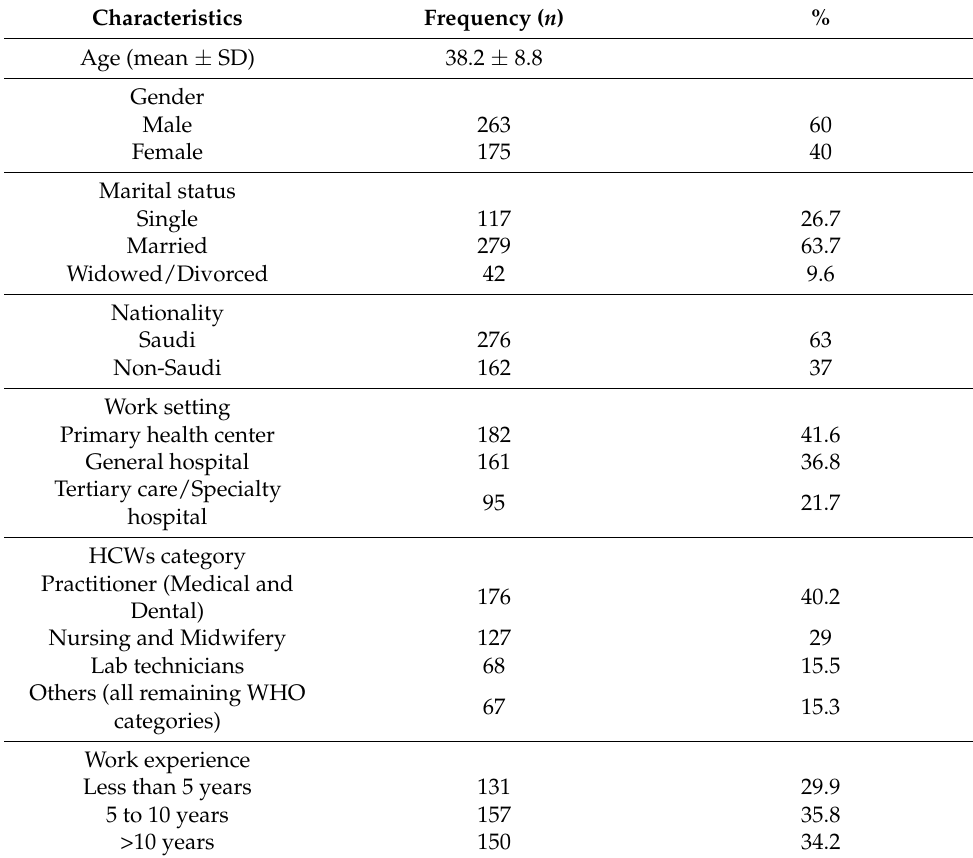
Table 1. Socio-demographic and lifestyle characteristics of study population ( n =